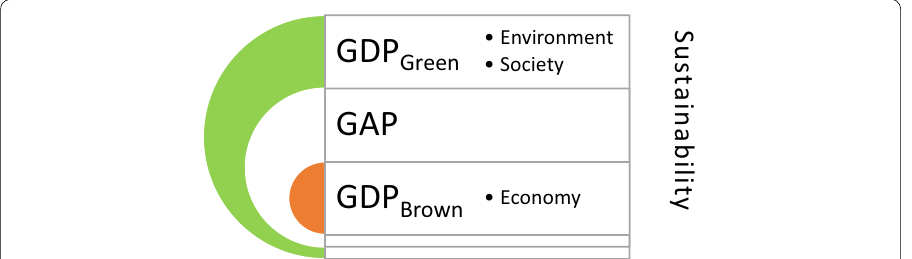
Fig. 2 Brown GDP versus green